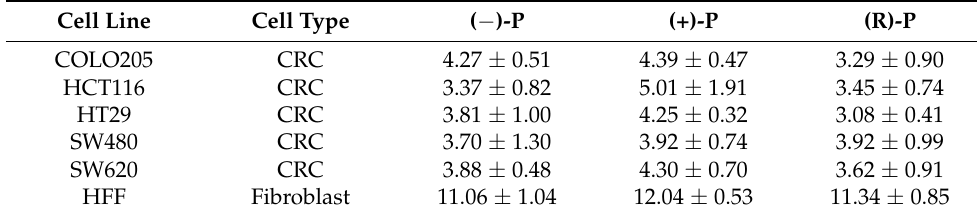
Table 1. The IC 50 of (+)-P, ( − )-P and (R)-P on cell lines tested expressed as mean ± SD ( µ M).